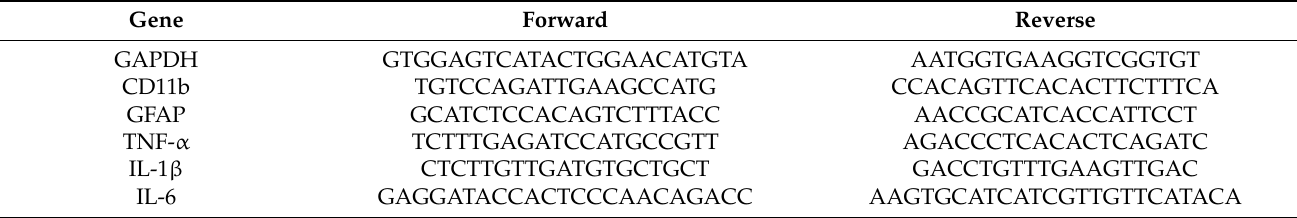
Table 1. Genes and primers for qRT-PCR (5 (cid:48) –3 (cid:48) ).